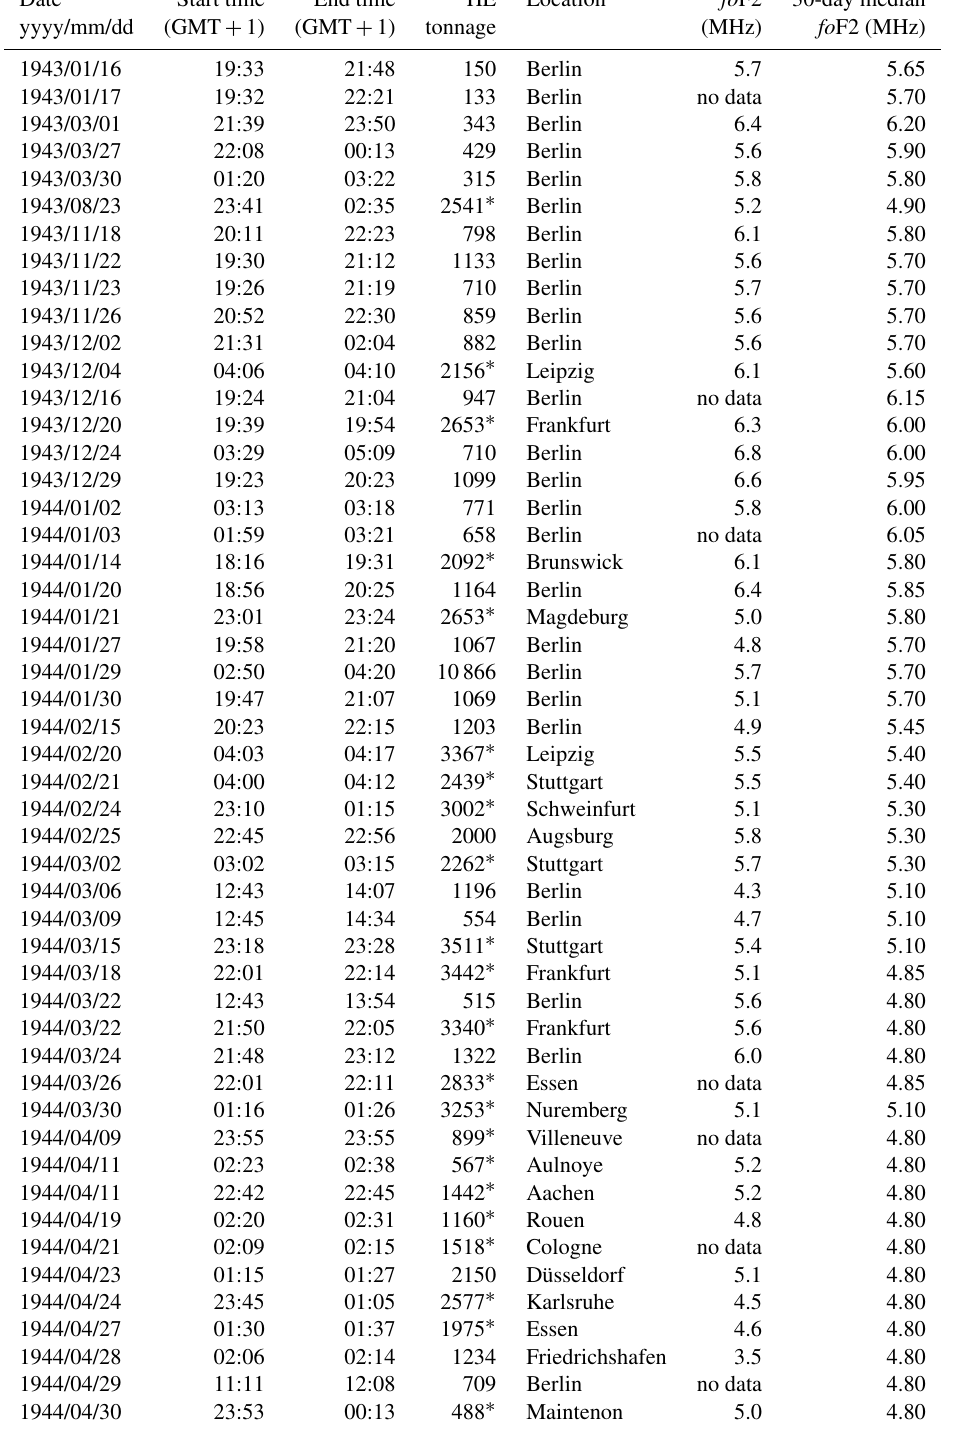
Table 1. Dates, times, locations and estimated tonnage of major bombing raids conducted over Europe between 1943 and 1945. Times for Berlin raids were taken from the duration of air-raid warnings (Demps, 2014). Other times were taken from a variety of eye-witness accounts (see Appendix A). Raids for which the total tonnage of HE bombs was estimated from the type and number of aircraft involved are marked with a ∗ . Noon values of fo F2 and 30-day running median fo F2 values over Slough corresponding to time = 0 in the superposed epoch analysis are presented in columns 6 and 7. Of the 152 events considered in this study, there are 29 days for which there is currently no noon fo F2 value